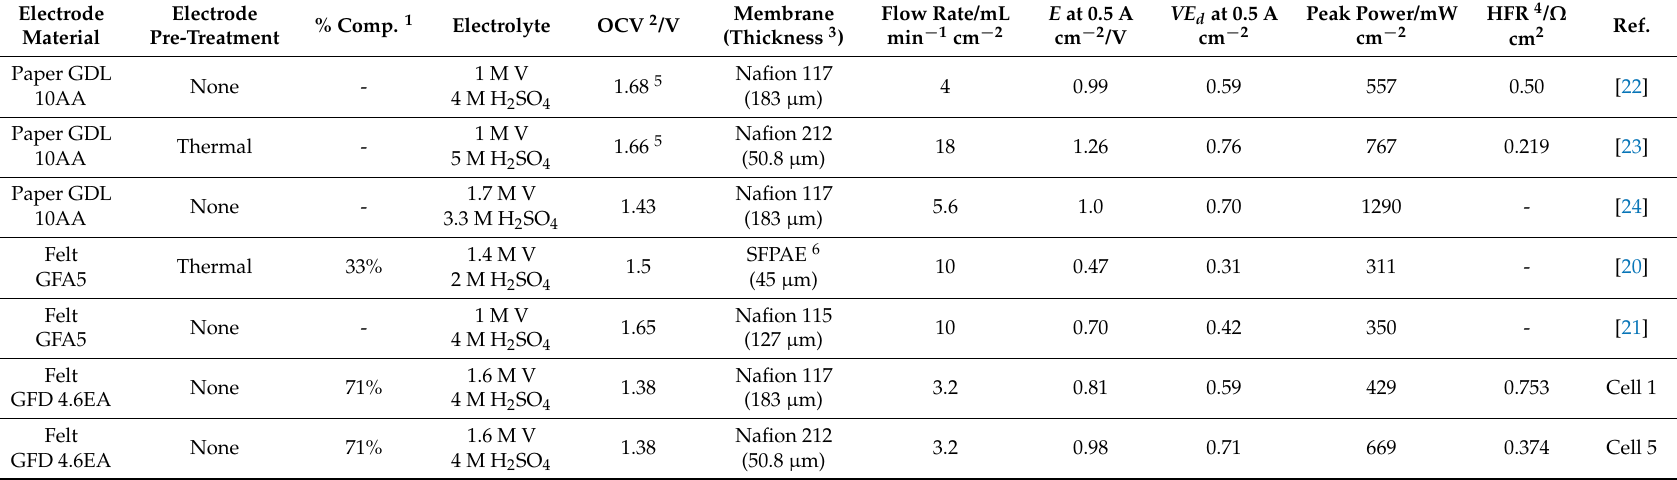
Table 2. Details of high performance VRFBs reported in the literature. The last two rows concern Cells 1 and 5 from the present